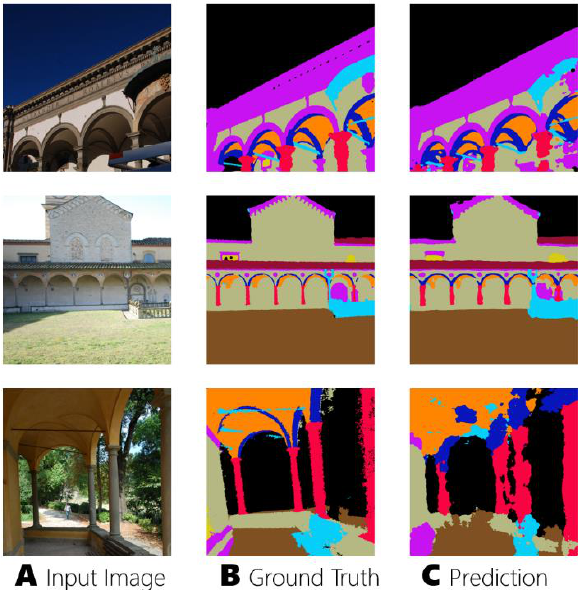
Figure 3: DeepLabv3+ results on the test set (Test 2): A) input image, B) ground-truth, C) prediction.